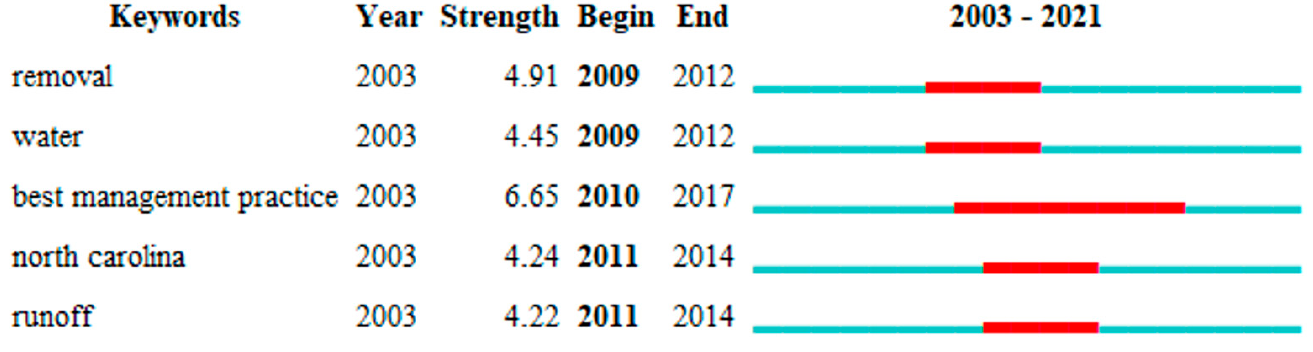
Figure 15. Top five emergent ecosystem vitality keywords.